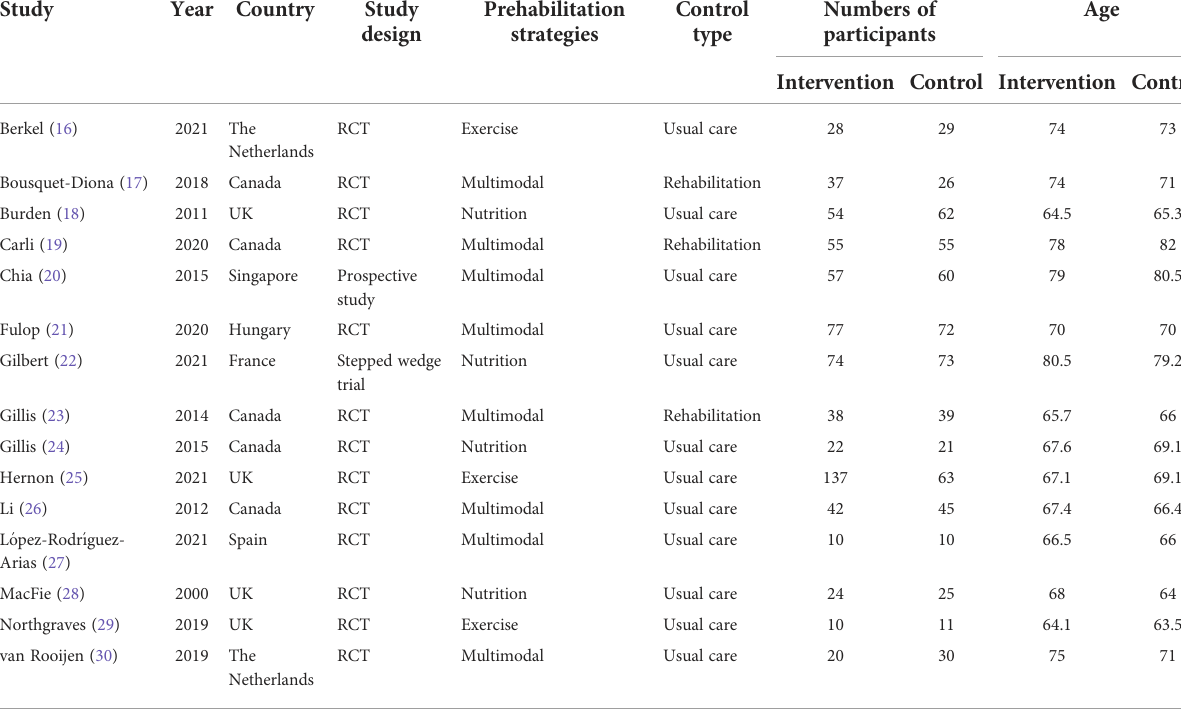
TABLE 1 Characteristics of included studies comparing prehabilitation versus standard care or rehabilitation among patients undergoing colorectal